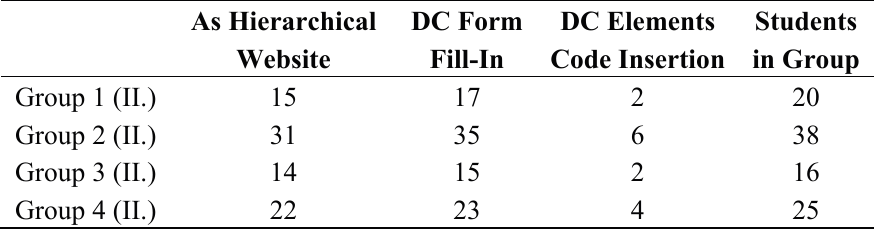
Table 4. Hierarchical window-management and publication. As Hierarchical DC Form DC Elements Website Fill-In Code